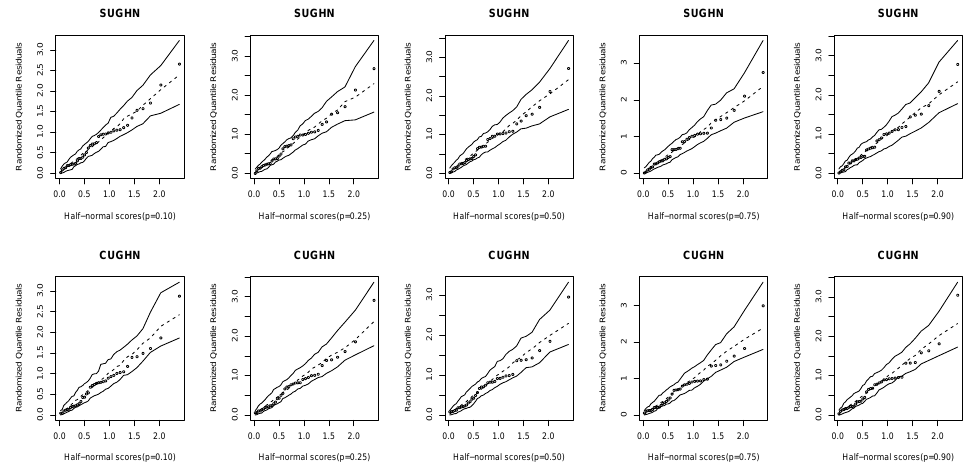
Figure 8. Half-normal plots of randomized quantile residuals of the SUGHN and CUGHN regression